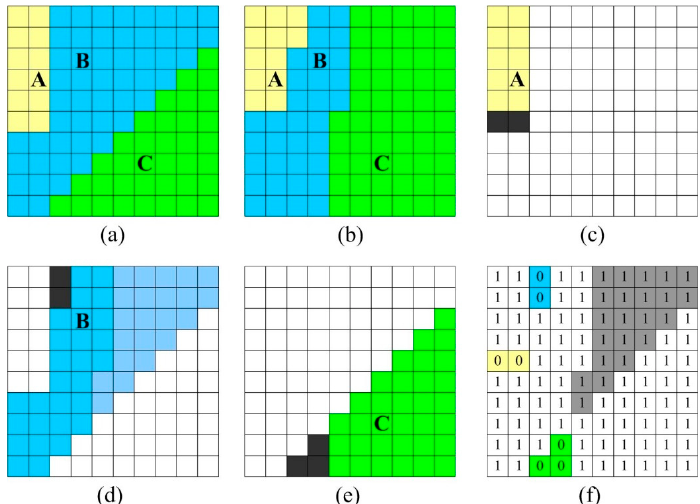
Figure 5. An example of cs A calculation: ( a ) Historic fine resolution pixels within a coarse resolution pixel. The scale factor is 10; ( b ) Corresponding current fine resolution pixels; ( c – e ) Fine resolution pixels of class A, B and C, as shown in ( a ), respectively. Pixels marked in color obey the change strategy, and pixels marked in black do not obey the change strategy; ( f ) The final indicator map, where 1 means that the pixel obeys the change strategy, and 0 means that the pixel does not obey the change strategy. Pixels marked in color and grey are changed pixels.